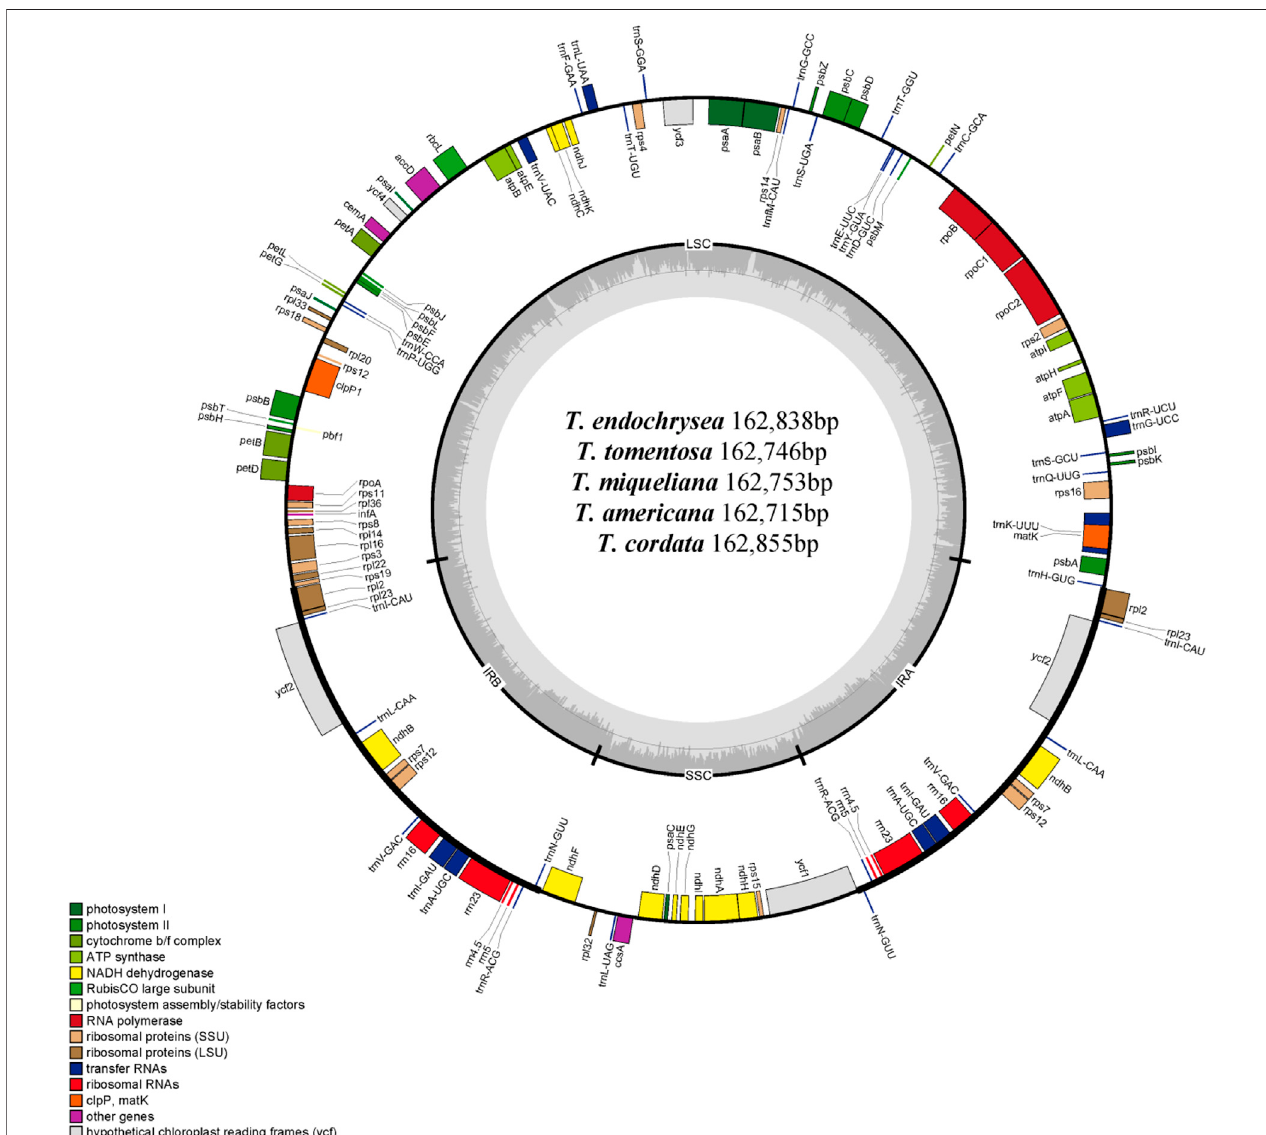
FIGURE 1 | Circular gene map of the chloroplast genomes of T. endochrysea , T. tomentosa , T. miqueliana , T. americana and T. cordata . Genes drawn within the circlearetranscribedclockwise,whereasthosedrawnoutsidearetranscribedcounterclockwise.Genesarecolor-codedinaccordancewiththeirfunctionalgroups.The inner circle represents the GC